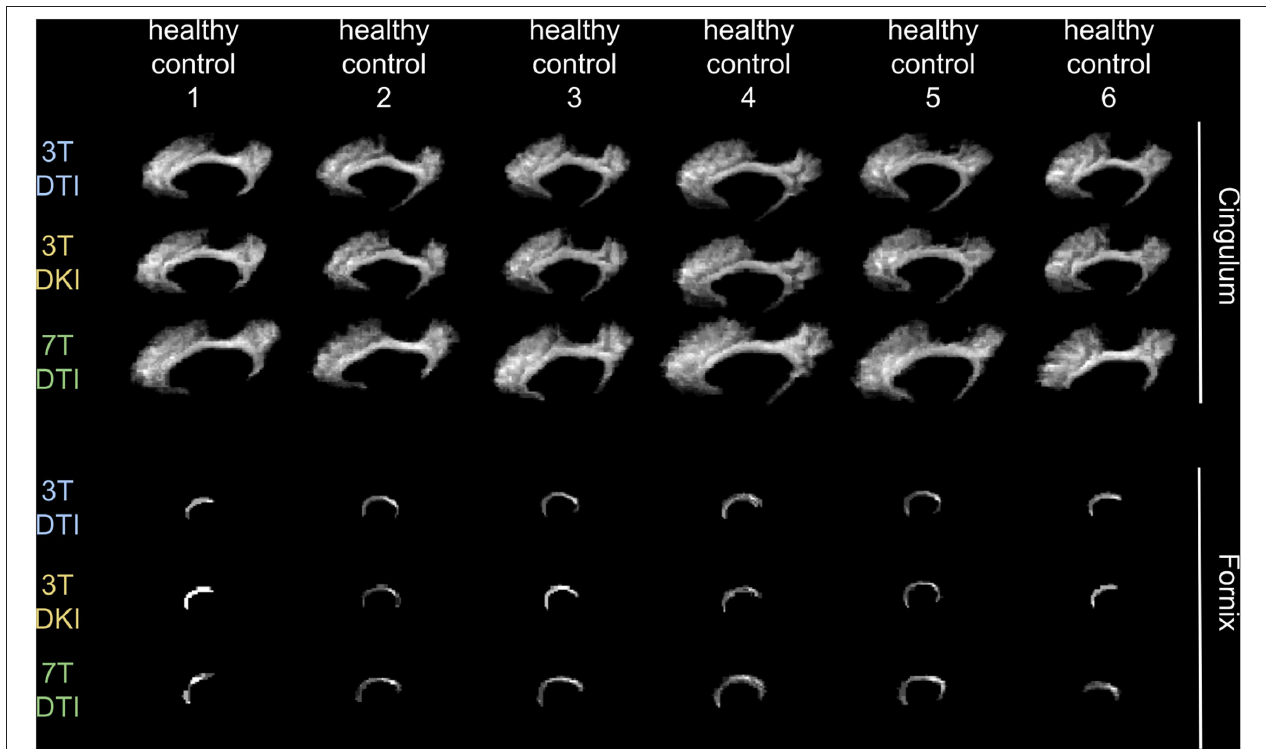
FIGURE 3 | Demonstration of how a tract’s volume change across six exemplar human controls for each of the three examined acquisition protocols. We chose to present the variation in the cingulum (top 3 rows) and in the fornix (bottom three rows), as an example of a tract that does not and does, respectively, challenge TractSeg in segmenting it. Note that the fornix is a very small tract in contrast to the cingulum that has a more recognizable shape, faciliating in that way TractSeg on segmenting it and vice-versa for the fornix.